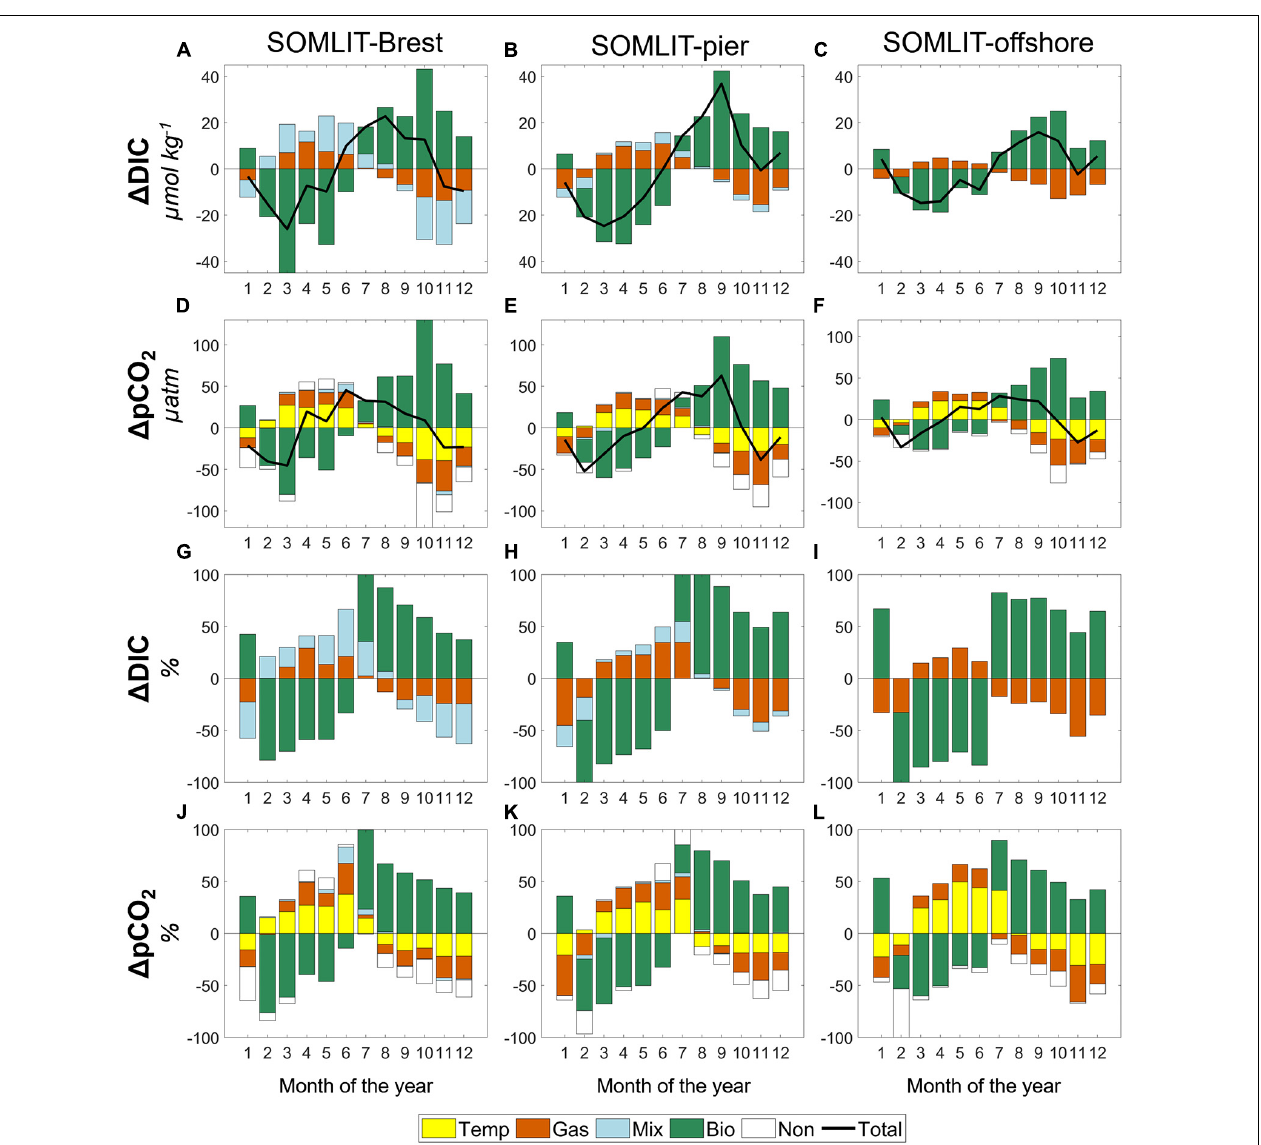
FIGURE 8 | (Top) Monthly means and (bottom) relative importance (%) of DIC ( µ mol kg − 1 ) and pCO 2 ( µ atm) changes due to thermodynamics ( (cid:49) x tem , in yellow), air–sea exchanges ( (cid:49) x gas , in vermillion), mixing ( (cid:49) x mix , in light blue), and biological activity ( (cid:49) x bio , in sea green) at (A,D,G,J) SOMLIT-Brest, (B,E,H,K) SOMLIT-pier, and (C,F,I,L) SOMLIT-offshore. (cid:49) x is the difference of pCO 2 or DIC between two consecutive months over the January 2010 to December 2017 period. Positive (or negative) values denote the increase (or decrease) between two consecutive months (see Section “Determination of Processes Controlling DIC/pCO 2 Based on a 1-D Mass Budget Model” for details on